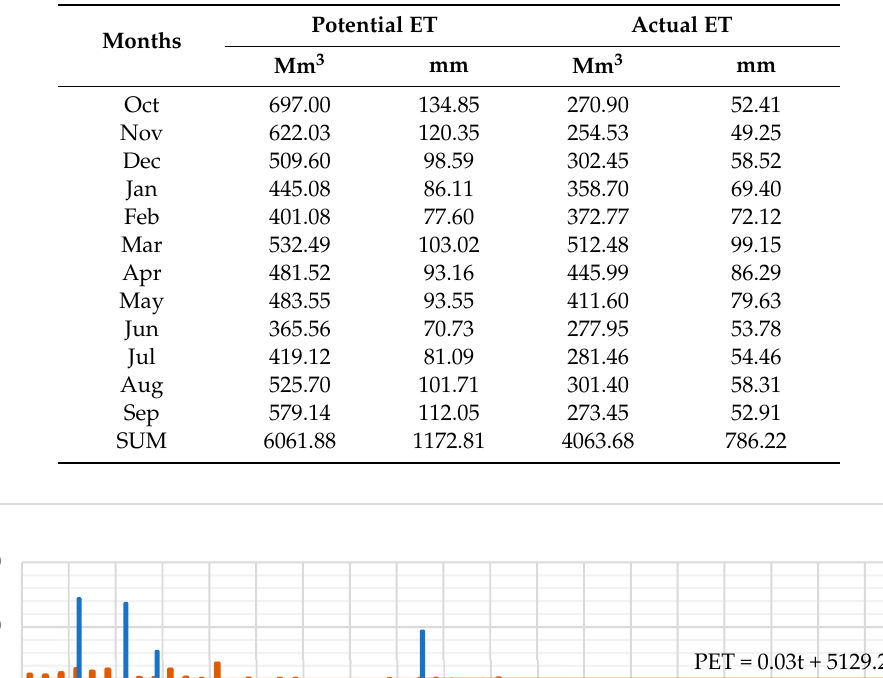
3581.90PET = 0.03t + 5129.20 P = -0.12t + 4603.12 AET = -0.24t +